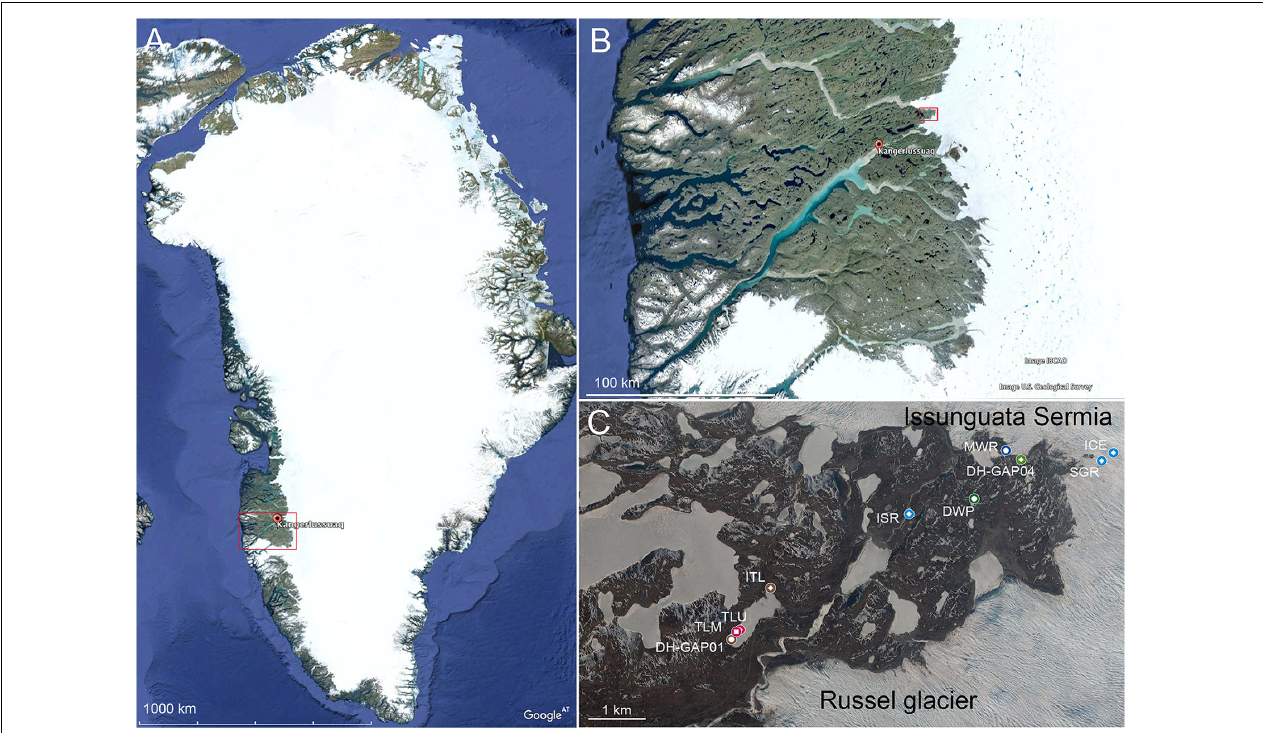
FIGURE 1 | The study area is located on the west coast of Greenland (A) in the Kangarlussuaq area (B) , which is indicated by the red square in A . The sampling area (C) is indicated by a red square in B . The sampling sites are indicated by colored symbols in C . The sample codes are explained in Table 1 . The white bar in the lower left corner of the figures represent 1000, 100, and 1 km in A , B , and C , respectively. DWP, drill water pond; TLU, talik lake up; TLM, talik lake mid; DH-GAP01, drillhole DH-GAP01; DH-GAP04, drillhole DH-GAP04; ICE, glacial ice from Issunguata Sermia; SGR, Supra Glacial River; MWR, melt water river directly below the glacier; ISR, Issunguata Sermia River; ITL, inflow to Talik lake. Maps from Google Earth